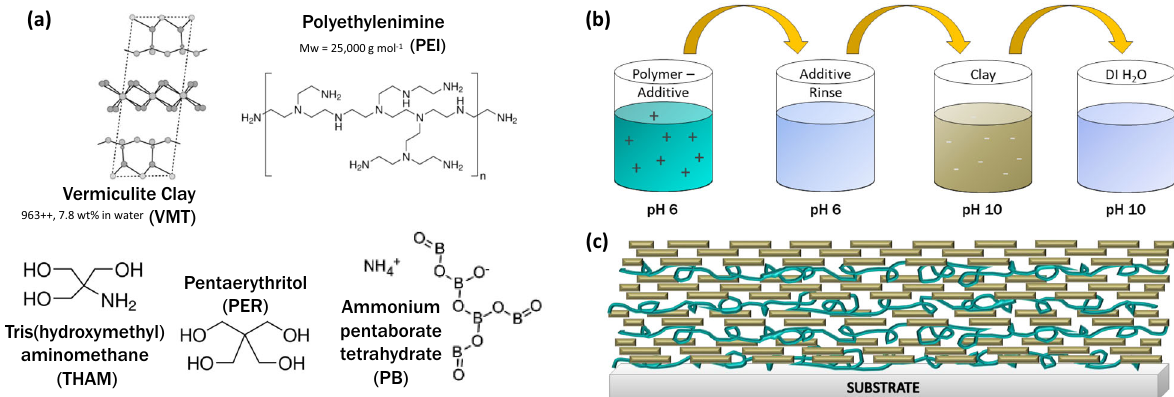
Fig. 1 Materials and methods. a Structure of polyethylenimine, vermiculite clay, tris(hydroxymethyl)aminomethane, pentaerythritol, and pentaborate. Schematics of the b layer-by-layer assembly process and c resulting multilayer nanobrick wall coating.